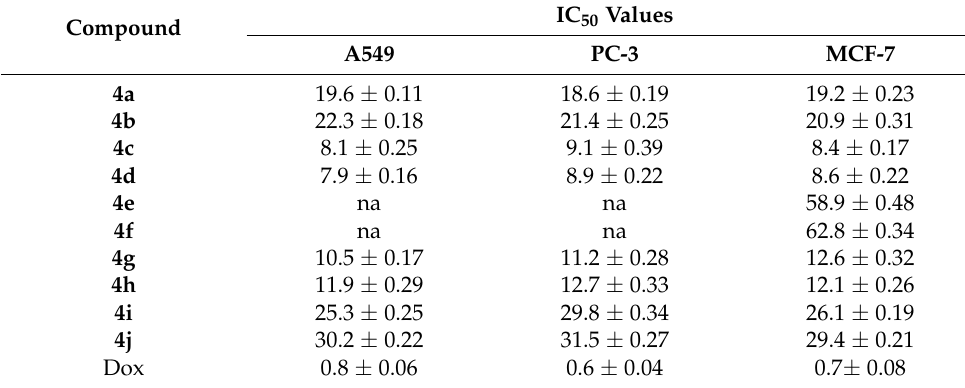
Table 3. Cytotoxicity data of novel indole-tethered chromenes 4a – j a